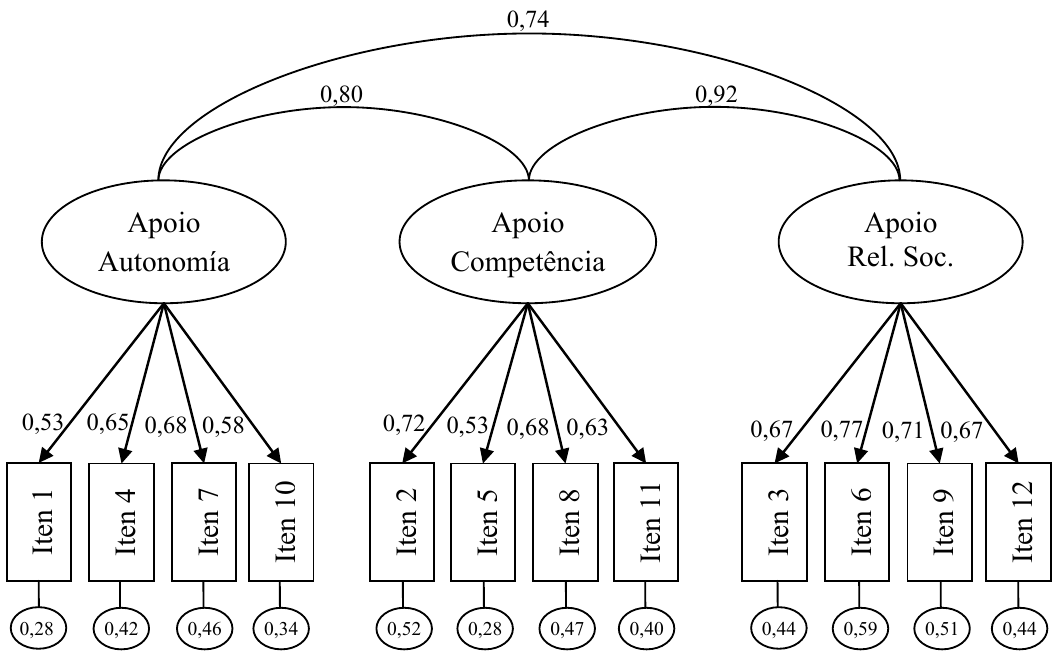
Figura 2 . Análise factorial con fi rmatoria. Nota . Rel. Soc. = Relações